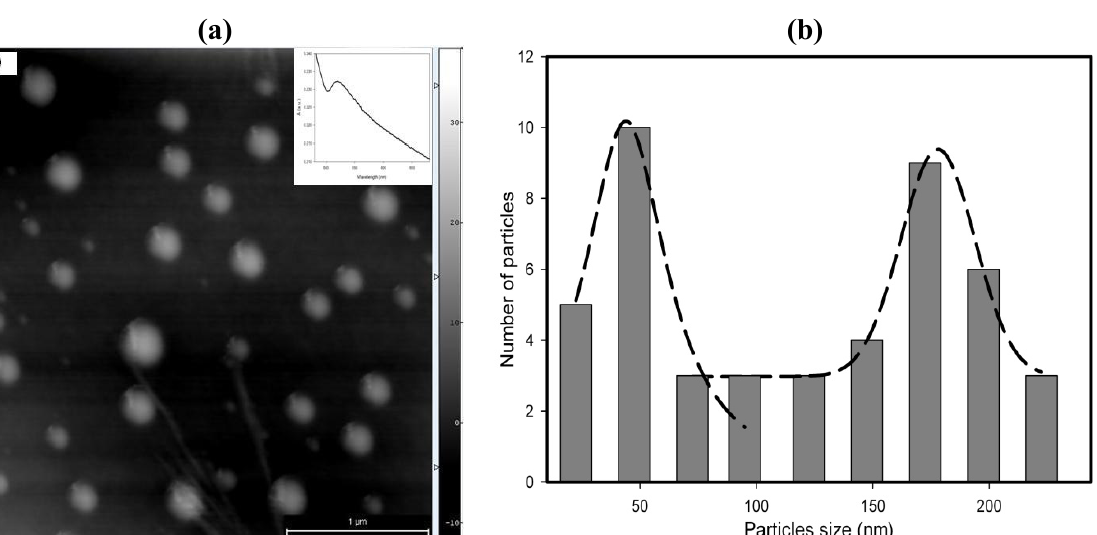
520 nm and corresponds to small (less than 5 nm) nanoparticles. In Figure 16 the spectra of Cu synthesized inside and outside the micro-reactor are compared. Figure 16. AFM image of Cu nanoparticles synthesized ( a ) at room temperature; ( b ) the corresponding size distribution. The spectrum of the stabilized Cu nanoparticles on a glass substrate is shown in the inset